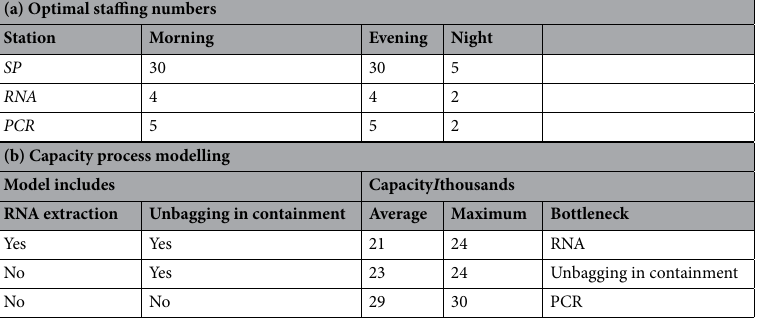
Table 1. Staffing and capacity modelling. ( a ) Optimal staffing numbers as defined by the process modelling described. ( b ) Capacity process modelling predictions—assuming a continuous process aligned to staffing numbers shown in (a); predicted process bottlenecks are highlighted. SP Sample Preparation Team, RNA RNA Extraction Team, PCR RT-qPCR Team, Unbagging in containment removal of sample secondary containment within a